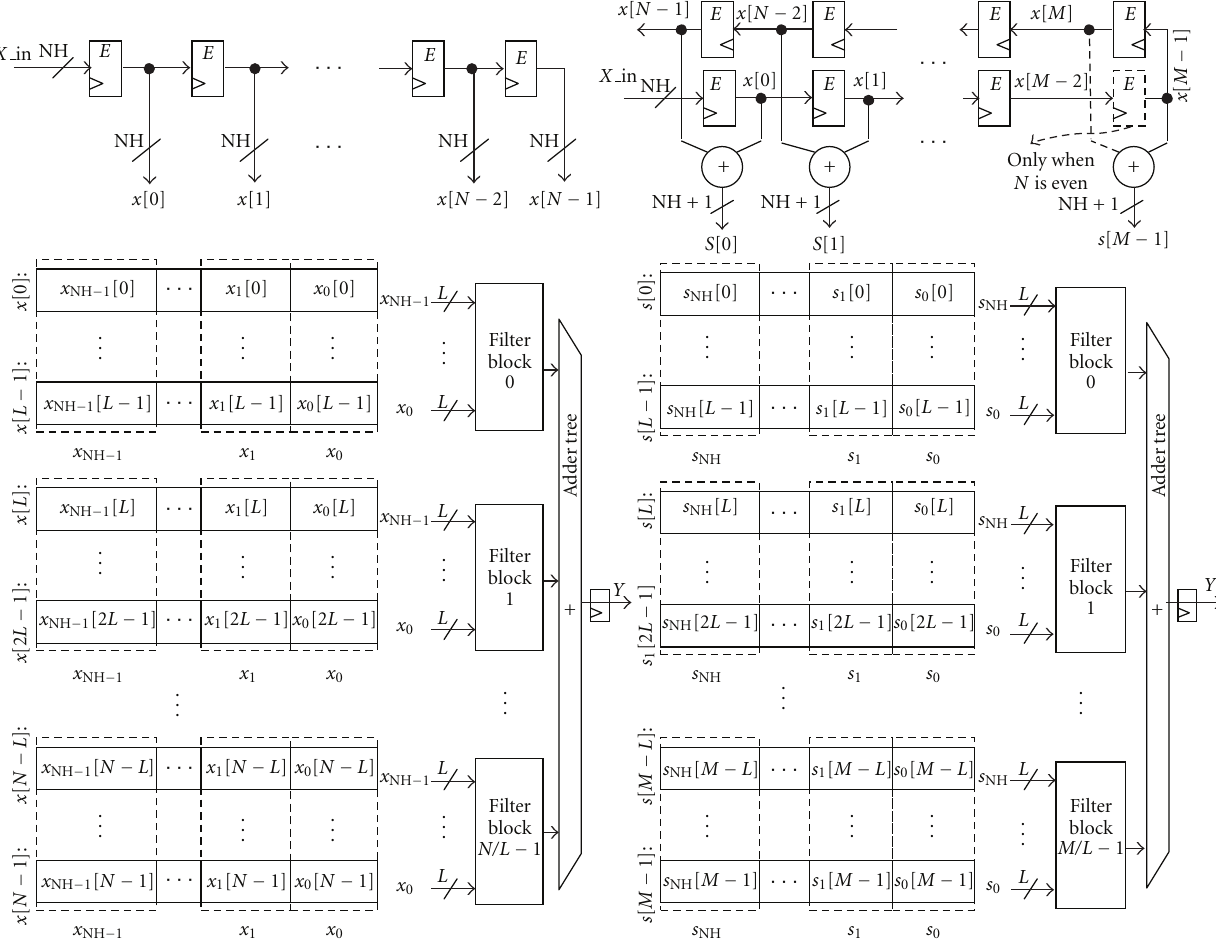
Figure 2: High-performance DA implementation based on the underlying LUT input size ( L ). Nonsymmetric filter (left) symmetric filter